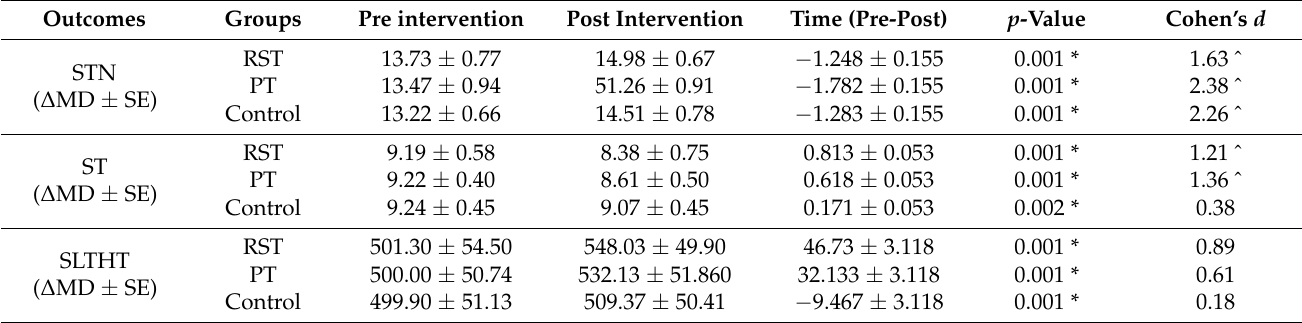
Table 3. Pairwise comparisons for the scores of the outcomes of the strength (STN), resisted sprint (ST), and muscle performances (SLTHT) across two time points within each group using Bonferroni’s multiple comparison test. Cohen’s d test was applied for measuring the effect size between the two time points.